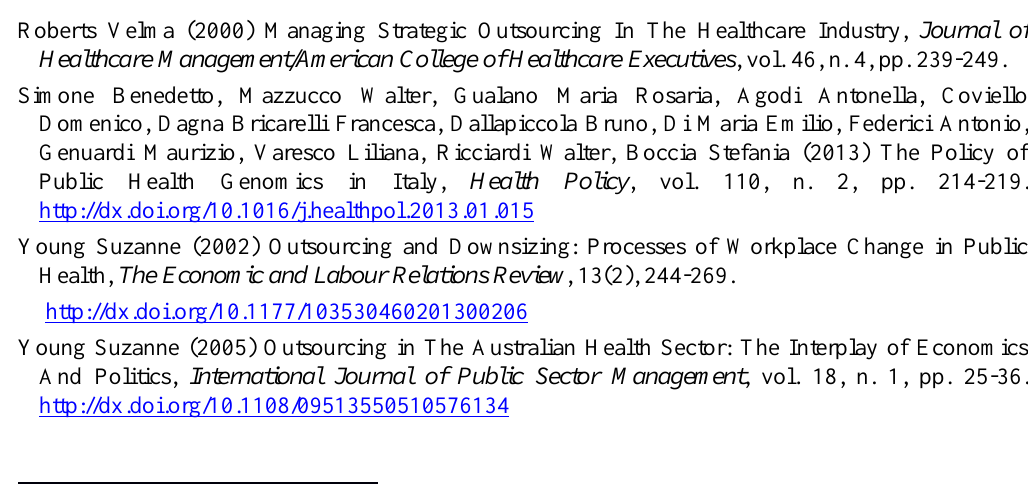
l’impiego. FABBRIS L.(editor) Definire figure professionali tramite testimoni privilegiati, Cleup, Padua, p.